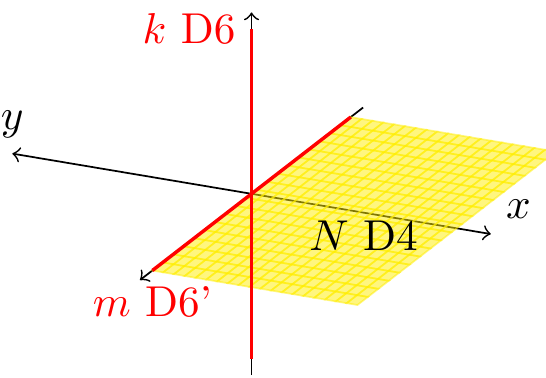
Figure 3. The resulting IIA brane content corresponding to N M5 branes on the w = 0 divisor k;m after reduction on the xy D w of the generalized conifold K